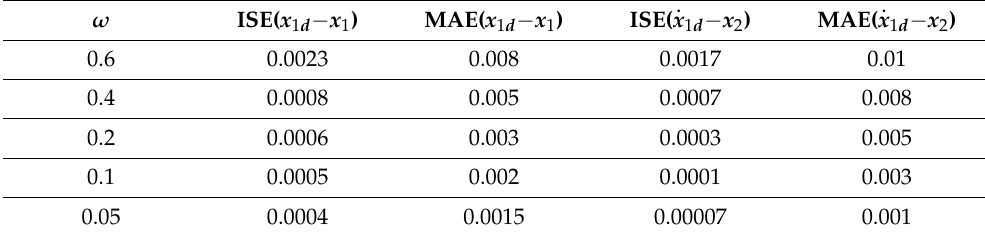
Table 5. Comparison of the quality indices ISE and MAE for the different values of 𝜔 .